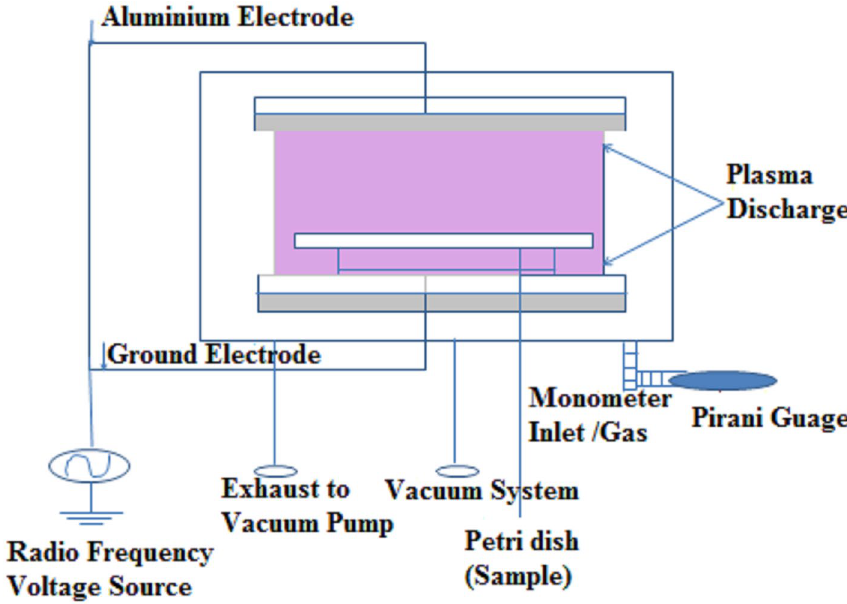
Figure 1. Schematic diagram of the low-temperature plasma